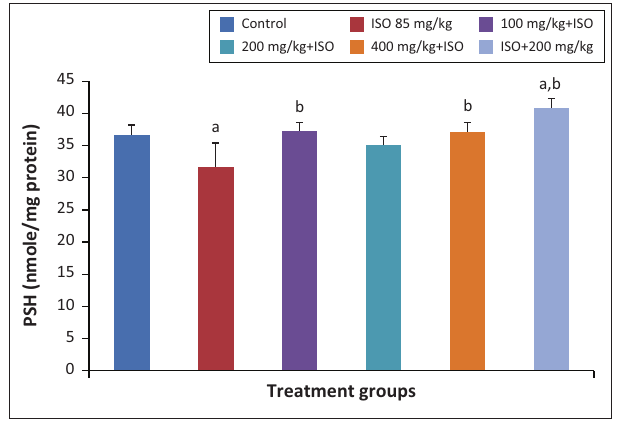
FIGURE 10: Effect of the ethanolic extract of Andrographis paniculata on protein thiol in isoproterenol-induced myocardial infarction using rats as a model ( n =